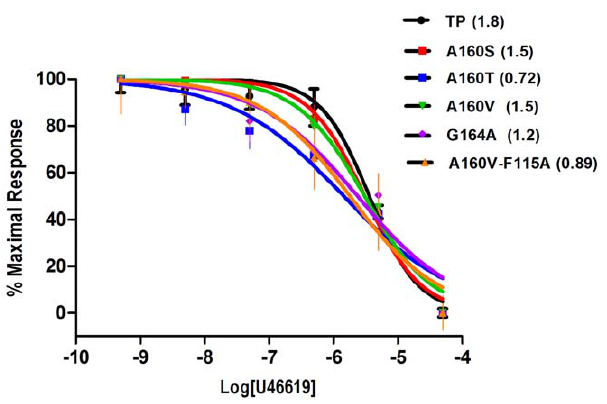
Figure 3. Heterologous competition curves of TP and select mutants using the unlabeled agonist U46619 and antagonist [ 3 H] SQ 29,548. The Ki values ( m M) are shown in parenthesis.